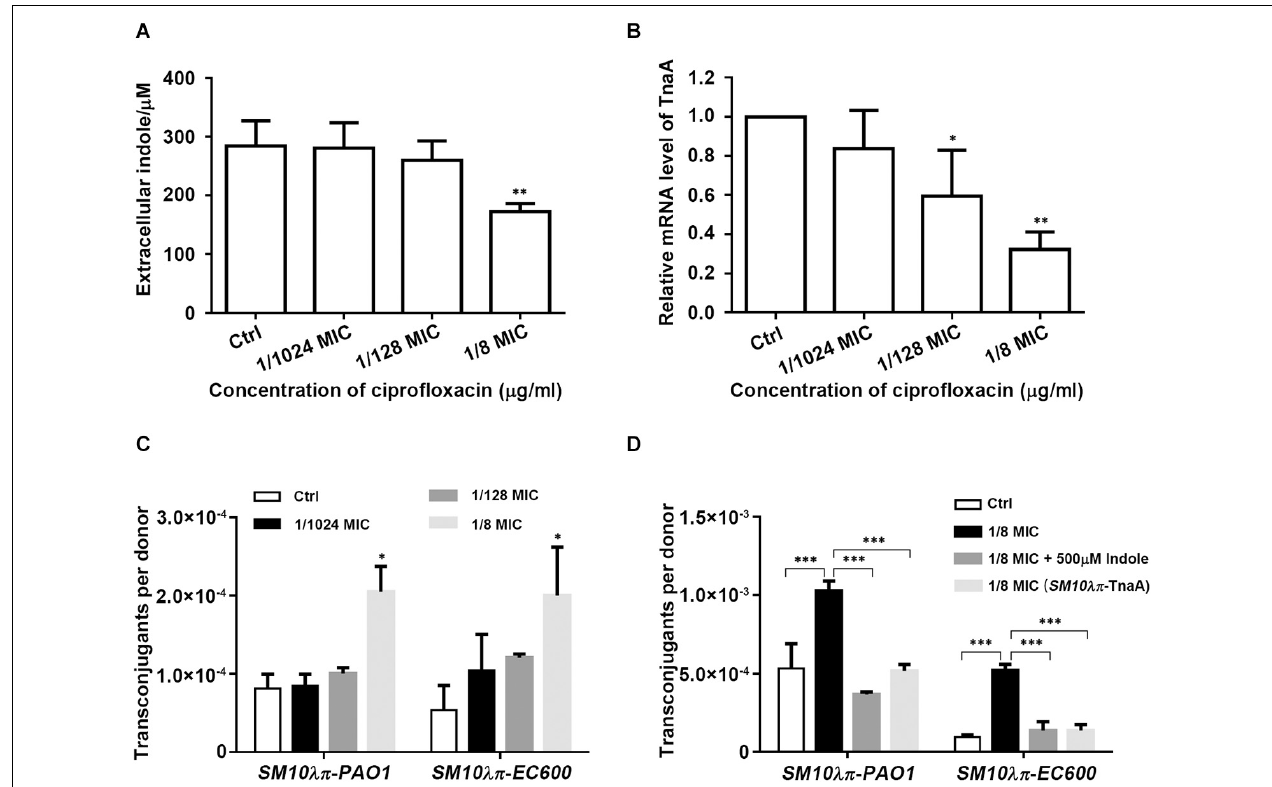
FIGURE 3 | Indole inhibited CIP-induced conjugation. (A) Effect of CIP on indole production. SM10 λπ was treated with different sub-MICs of CIP at 37 ◦ C for 5 h, followed by measurement of extracellular indole. (B) Effect of CIP on tnaA expression. SM10 λπ was treated with different sub-MICs of CIP at 37 ◦ C for 4 h, followed by real-time PCR analysis of tnaA expression. (C) Effect of CIP on SM10 λπ - PAO1 and SM10 λπ - EC600 conjugation. SM10 λπ was treated with different sub-MICs of CIP at 37 ◦ C for 8 h and then mated with PAO1 or EC600 cells at 37 ◦ C for 6 h. (D) Indole inhibited CIP-induced conjugation frequency. SM10 λπ was treated with 1/8 MIC of CIP at 37 ◦ C for 8 h and then mated with PAO1 or EC600 cells in the presence of 500 µ M of indole at 37 ◦ C for 6 h; meanwhile, overexpression of TnaA in wild-type ( SM10 λπ -TnaA) was treated with 1/8 MIC of CIP at 37 ◦ C for 8 h and then mated with PAO1 or EC600 cells at 37 ◦ C for 6 h. Values are means ± SEMs from at least three independent experiments; ∗ P < 0.05; ∗∗ P < 0.01; ∗∗∗ P <